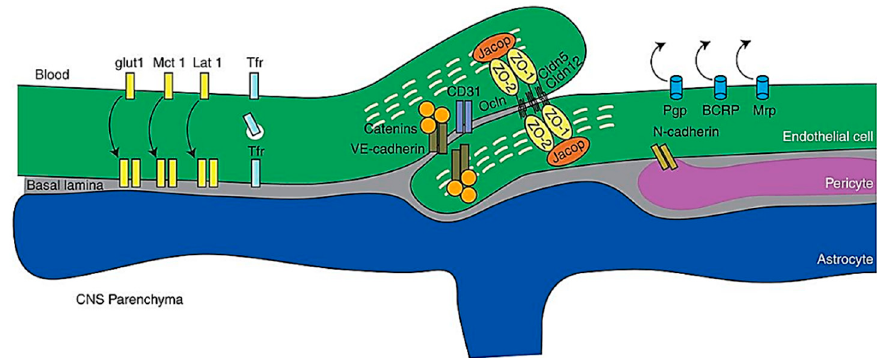
Figure 6. Schematic representation of molecules of the BBB. Abbreviations: CNS, central nervous system; VEcad, VE cadherin. Reproduced from [97], with permission from Cold Spring Harbor, 2017.